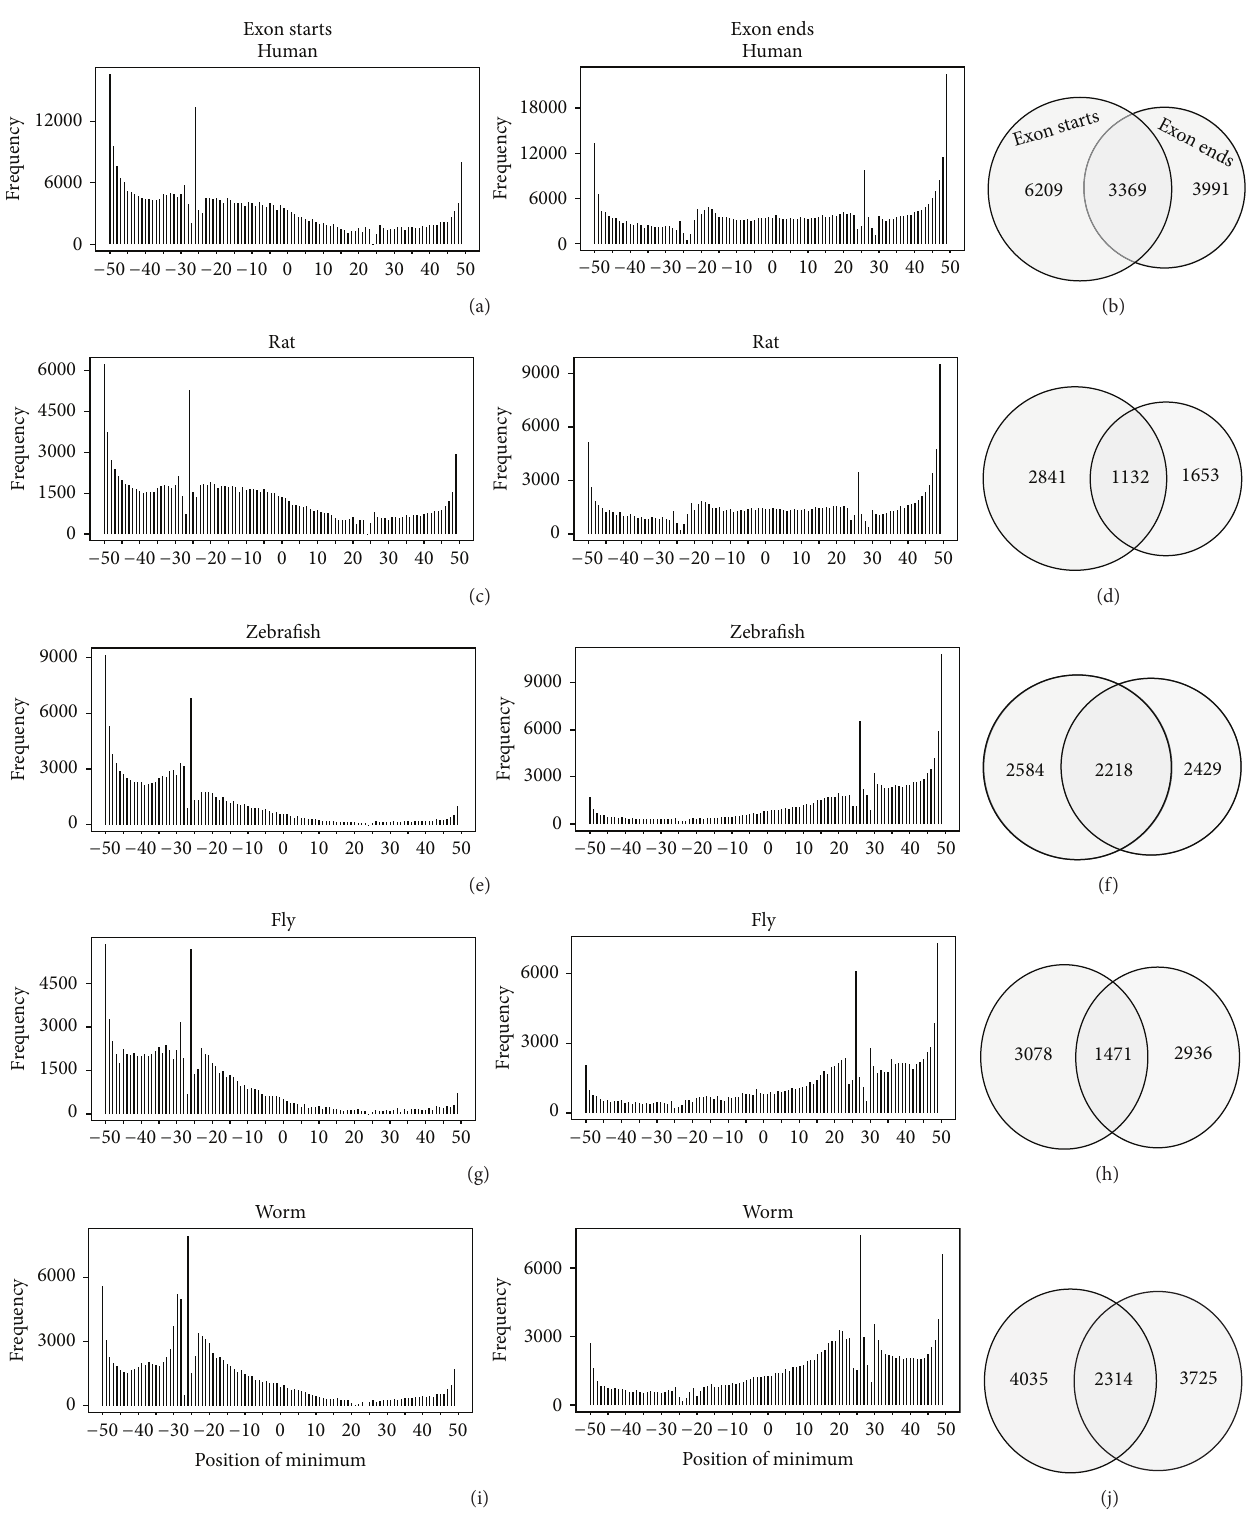
Figure 2: Counts of exons and genes grouped by location of minimum NOL score in the region +/ − 50bp from the annotated boundary between intron and exon. ((a), (c), (e), (g), and (i)) Histograms for human, rat, zebrafish, fly, and worm showing the counts of minimum values at each position in the region +/ − 50bp from the annotated intron/exon (exon starts) and exon/intron (exon ends) boundaries. ((b), (d), (f), (h), and (j)) Venn diagrams indicating the numbers of genes represented in the − 26 peak for exon starts and +26 peak for exon ends and the overlap between the two